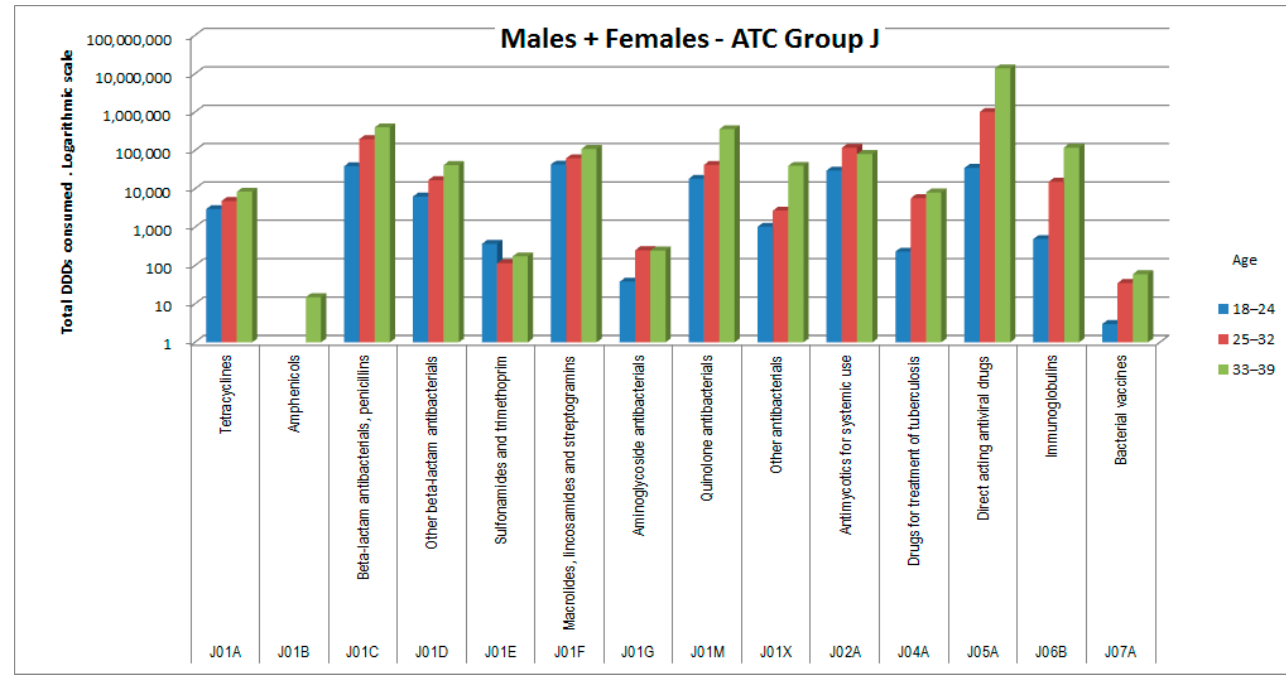
Figure 12. DDD consumption for males, ATC group Hxxx.